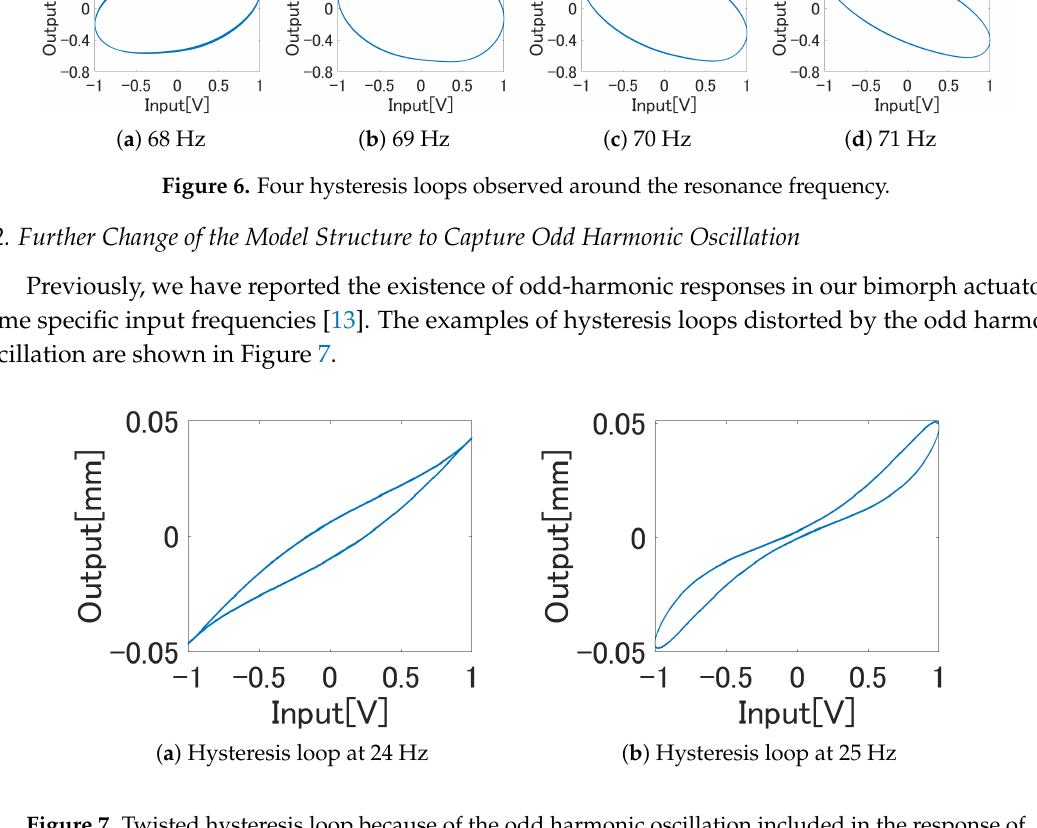
Figure 7. Twisted hysteresis loop because of the odd harmonic oscillation included in the response of the